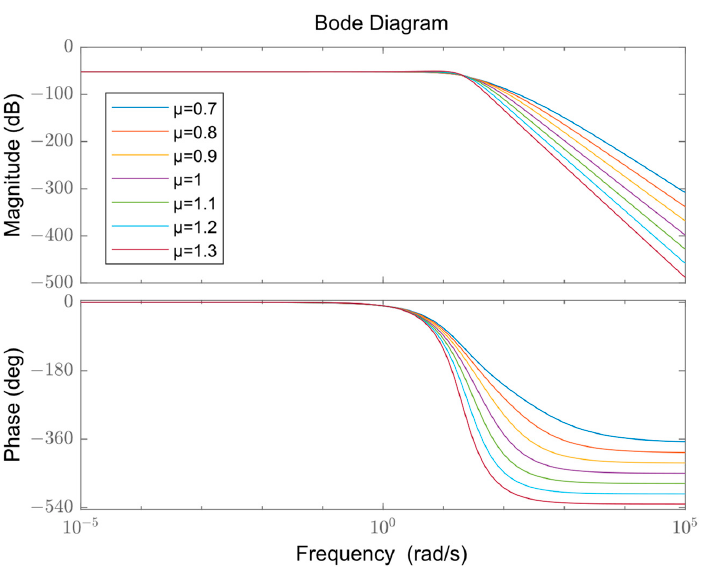
Figure 4. Bode Diagram of G fz3.